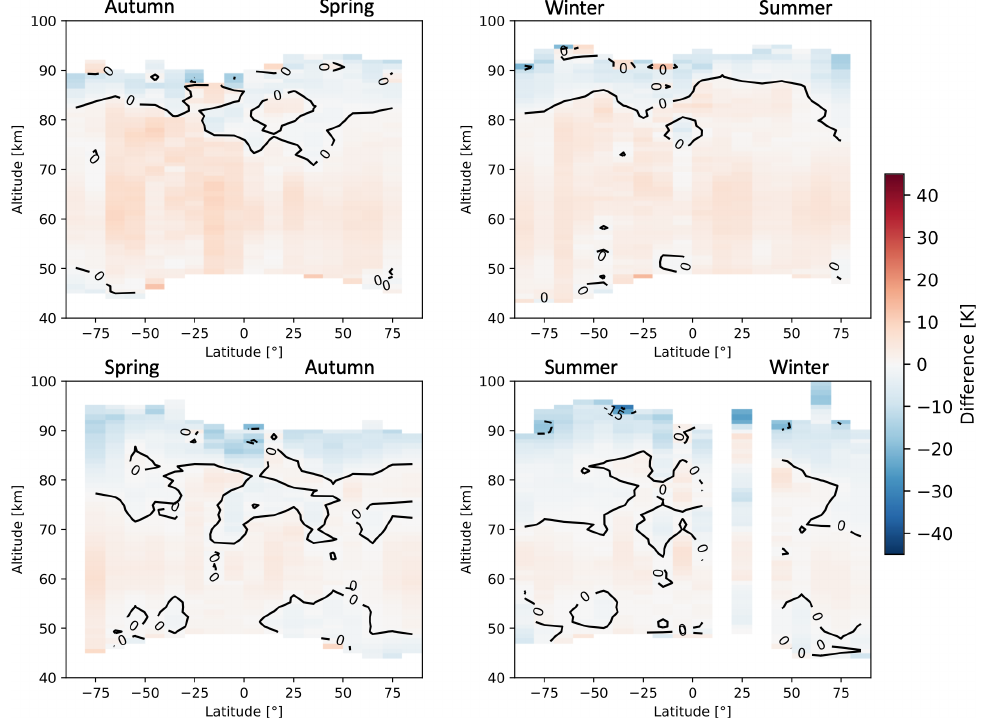
Figure A27. Seasonal zonal means of temperature FM13 SMR–ACE absolute differences averaged over the time period between February 2004 and April 2019. The seasons are intended as astronomical seasons, i.e. each starting at the respective solstice or equinox.